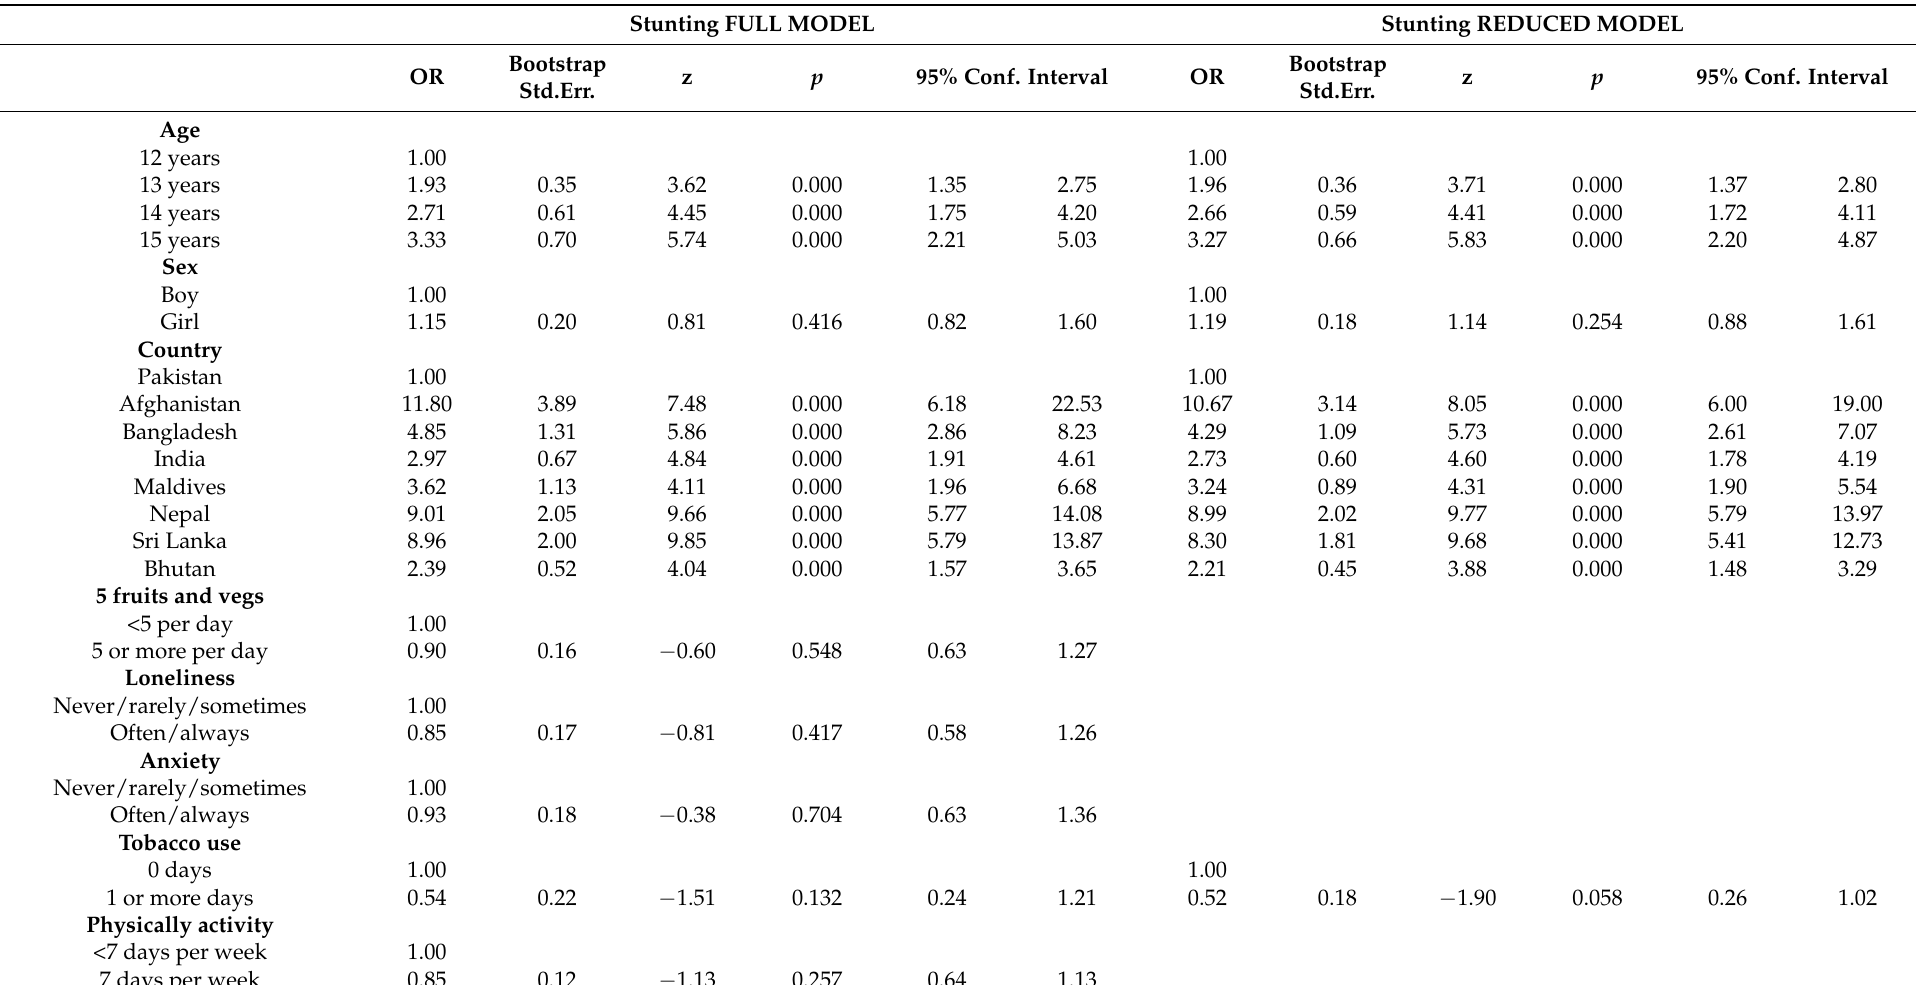
Table 6. Multivariable logistic regression model for adolescent stunting in South Asia, GSHS datasets. Stunting FULL MODEL Stunting REDUCED MODEL Bootstrap OR Std.Err.